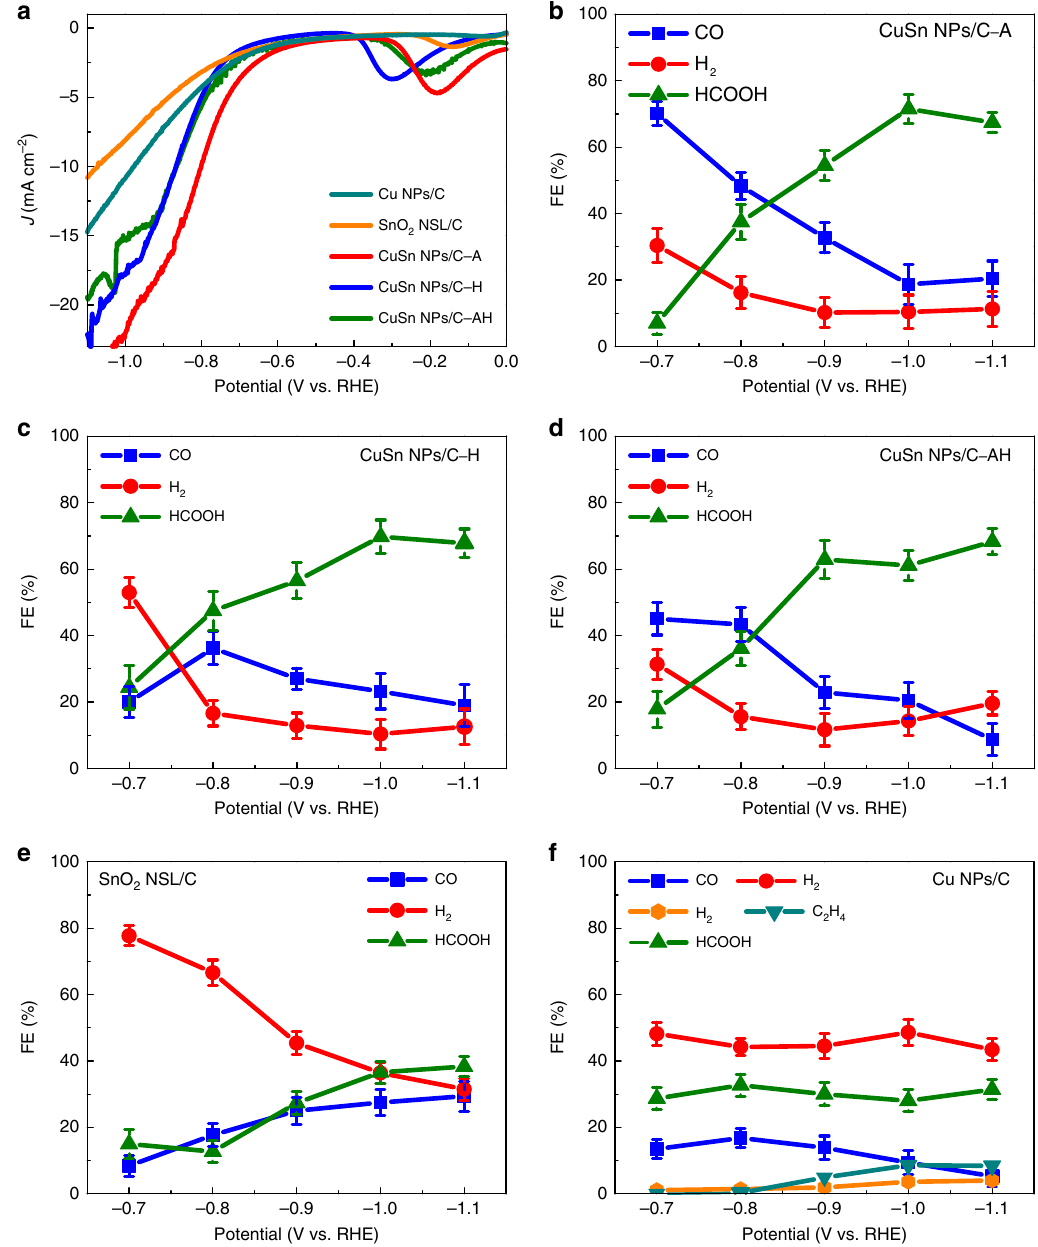
Fig. 3 Electrochemical CO 2 reduction performance of various Cu – SnO 2 catalysts, Cu NPs/C and SnO 2 NSL/C. a Linear sweeping voltammetric curves of electrochemical CO 2 reduction measured in 0.1 M KHCO 3 for different catalysts. Scan rate: 5 mV s − 1 . Reduction potential-dependent faradaic ef fi ciencies (FEs) of H 2 , CO, and HCOOH for b CuSn NPs/C-A, c CuSn NPs/C-H, d CuSn NPs/C-AH, e SnO 2 NSL/C, and f Cu